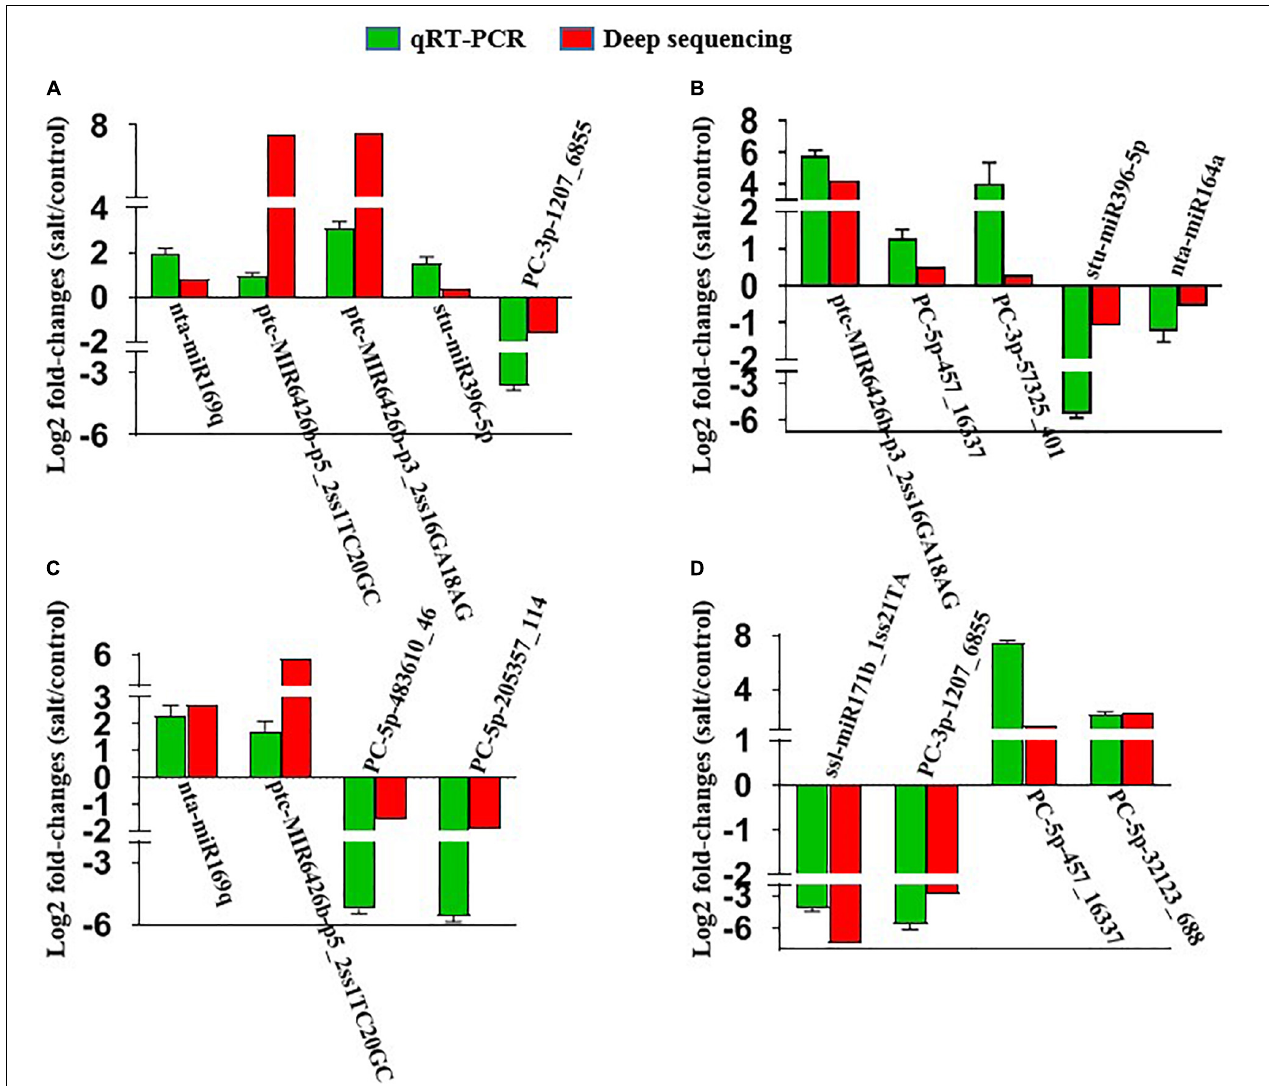
FIGURE 7 | QRT-PCR validation of randomly selected salt-responsive miRNAs in the leaves and roots of two sweetpotato cultivars. (A) MiRNAs in “Xushu 22” roots; (B) miRNAs in “Xushu 22” leaves; (C) miRNAs in “Xushu 32” roots; (D) miRNAs in “Xushu 32” leaves. Each bar represents a miRNA with log 2 fold change (2 − (cid:49)(cid:49) Ct ) in expression. Data are displayed as averages ± SD (n = 3 PCR